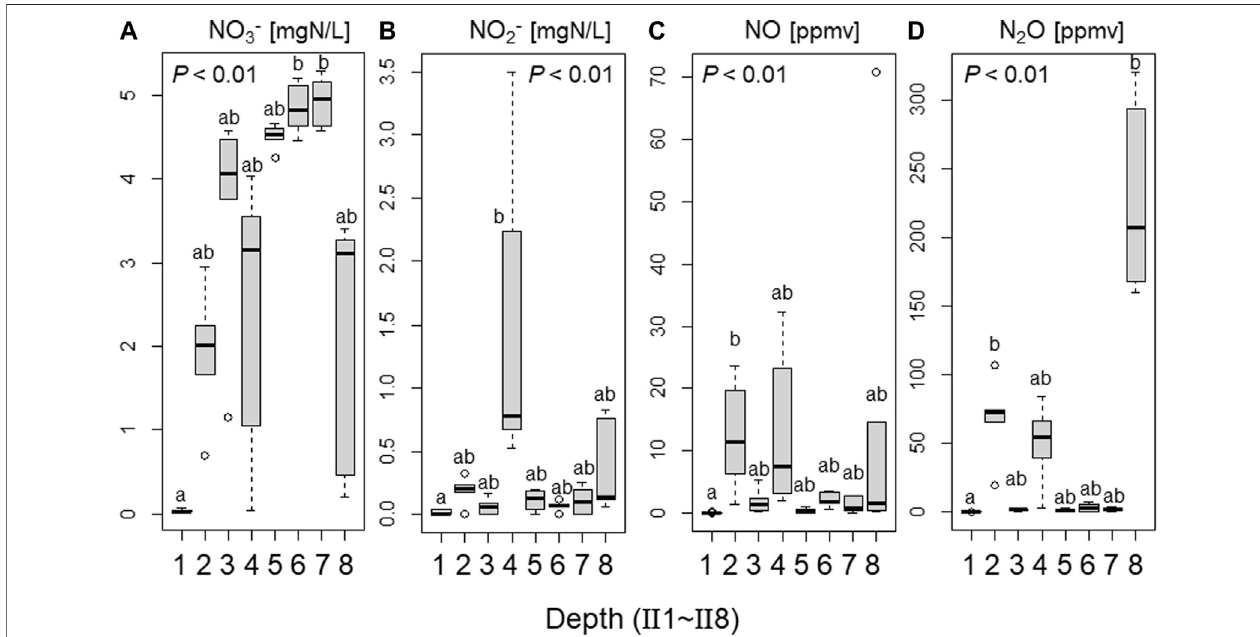
FIGURE 7 | Comparisons of NO 3 − , NO 2 − , NO, and N 2 O concentrations between depths in the short-term incubation experiment using soils of streambank II. Thick line indicates median value, rectangle 25 – 75% of values. Different letters indicate signi fi cant differences detected using Kruskal – Wallis test followed by Steel – Dwass test ( p < 0.05).